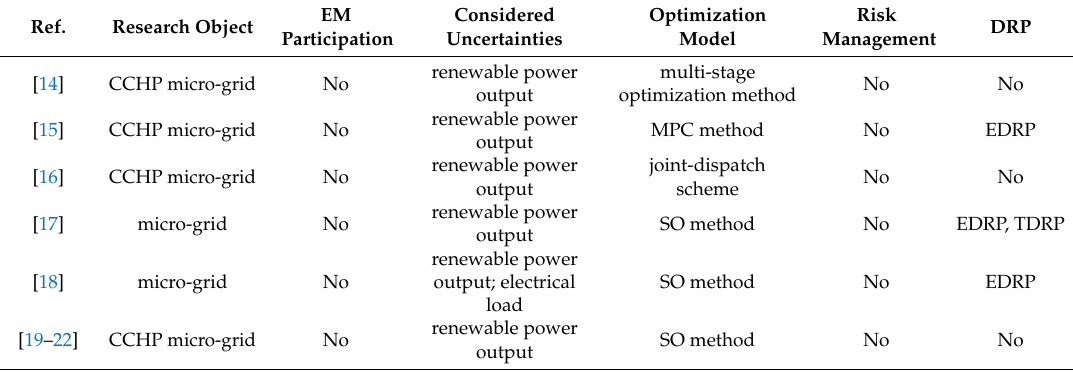
Table 1. Summarization of literature